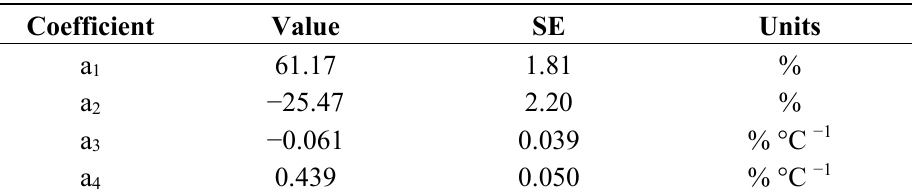
Table 4. Values and standard errors (SE) of the empirical “a” coefficients of Equation (1) which were used to calculate percent transmission of incident radiation into the greenhouse used in the study of soybean flowering